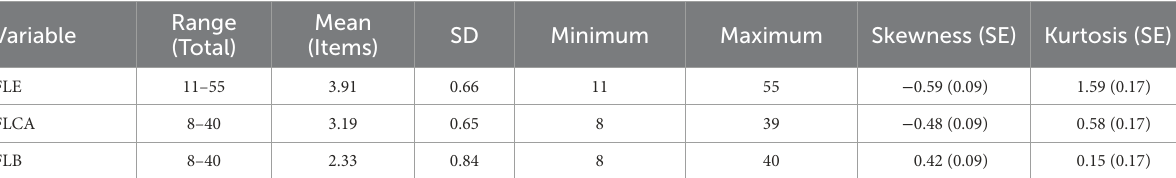
TABLE 1 Levels of FLE, FLCA, and FLB.